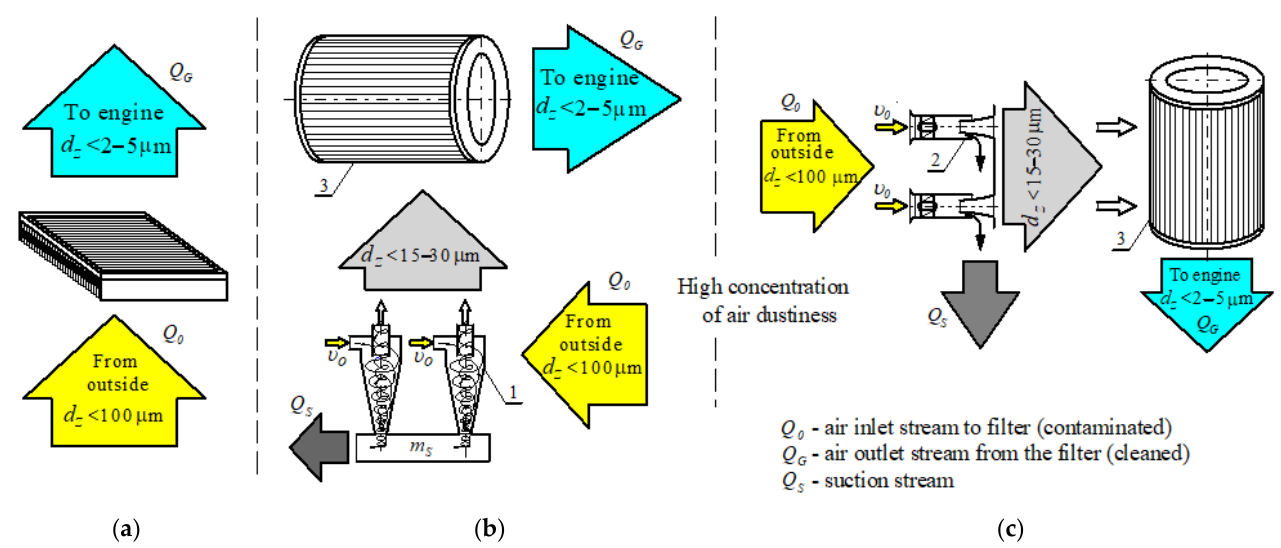
Figure 1. Air filtration system in the filter: ( a ) single ‐ stage (porous barrier); ( b ) two ‐ stage (multi ‐ cyclone of return cyclones with a tangential inlet–porous barrier); ( c ) two ‐ stage (multi ‐ cyclone of axial plow cyclones–porous barrier).